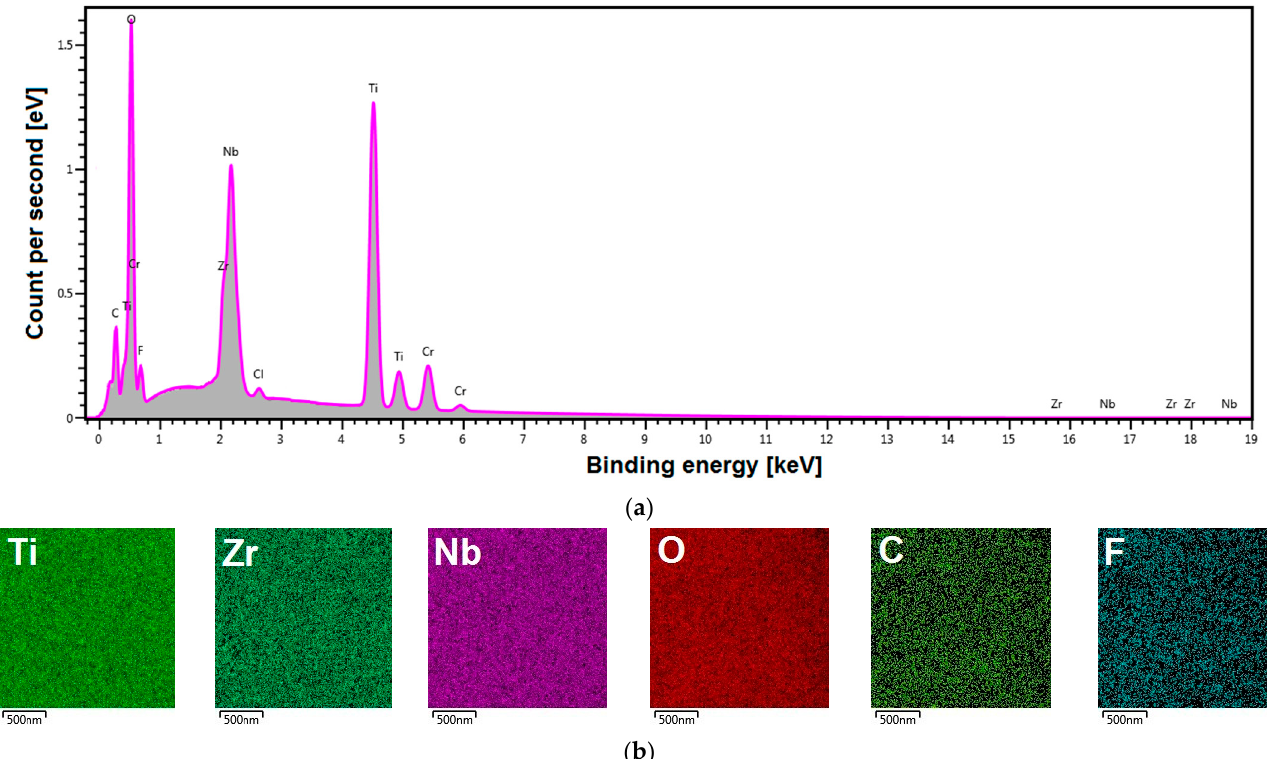
Figure 5. Local chemical composition of the Ti–13Zr–13Nb alloy with the 2G ONTs layer: ( a ) Energy dispersive spectrum in the micro ‐ region; ( b ) EDS maps of elements distribution (Ti, Zr, Nb, O, C, F) in the micro ‐ region.